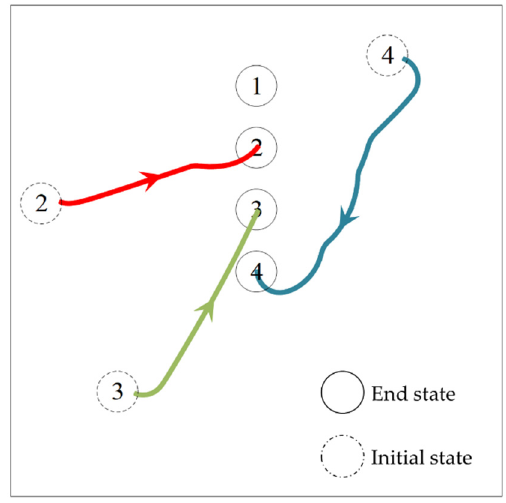
Figure 20. Reconfiguration path in one picture.